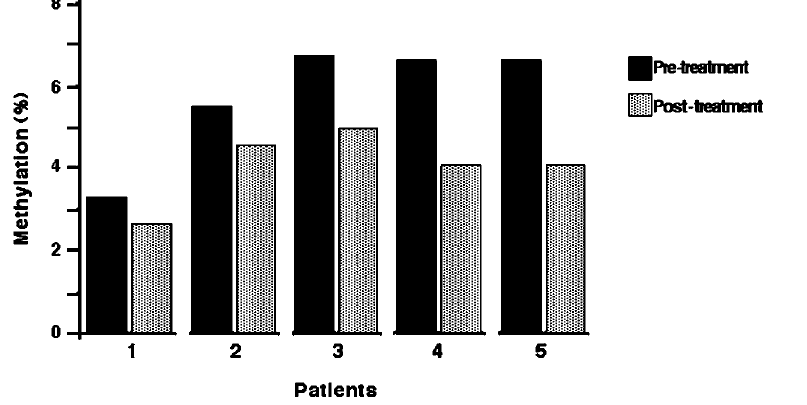
Figure 2. Global DNA methylation. The five patients had a reduction in 5mC content varying from 0.7 2 2.59% decrease. The mean 5mC in the five pre-treatment samples was 5.71% (standard deviation [SD], 1.43) which decreased to 4.2% (SD, 0.95). This difference was statistically significant (p=0.043).